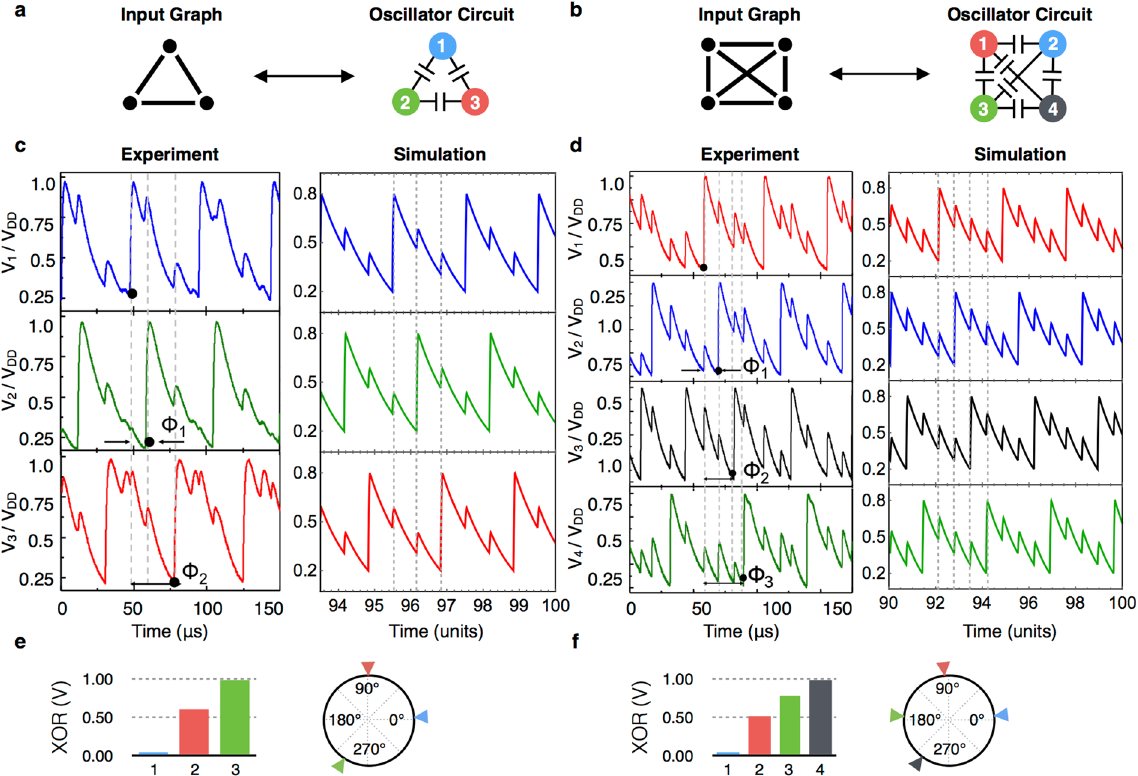
Figure 3. Phase dynamics of synchronized VO 2 based capacitively coupled relaxation oscillators. ( a,b ) Schematics of two representative configurations (a: delta configuration; b: cross-connected ring) of capacitively coupled VO 2 based oscillators, and their corresponding graphs. ( c,d ) Time domain waveforms from experiment and simulations for the two coupled oscillator configurations in ( a,b ), respectively, showing that while the oscillators are synchronized in frequency, no two directly coupled oscillators are in-phase. This important property of the coupled oscillator system enables graph coloring. ( e,f ) Time averaged XOR of thresholded outputs of oscillators (each w.r.t. oscillator number 1), and respective polar phase plots showing steady state relative phases detected using PFDs. The XOR values are normalized with respect to the maximum